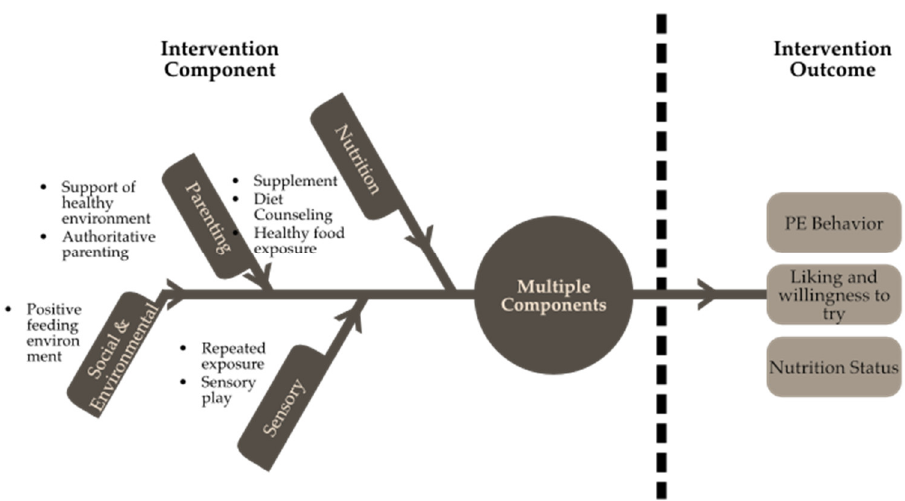
Figure 2. Multi-component intervention in PE children.